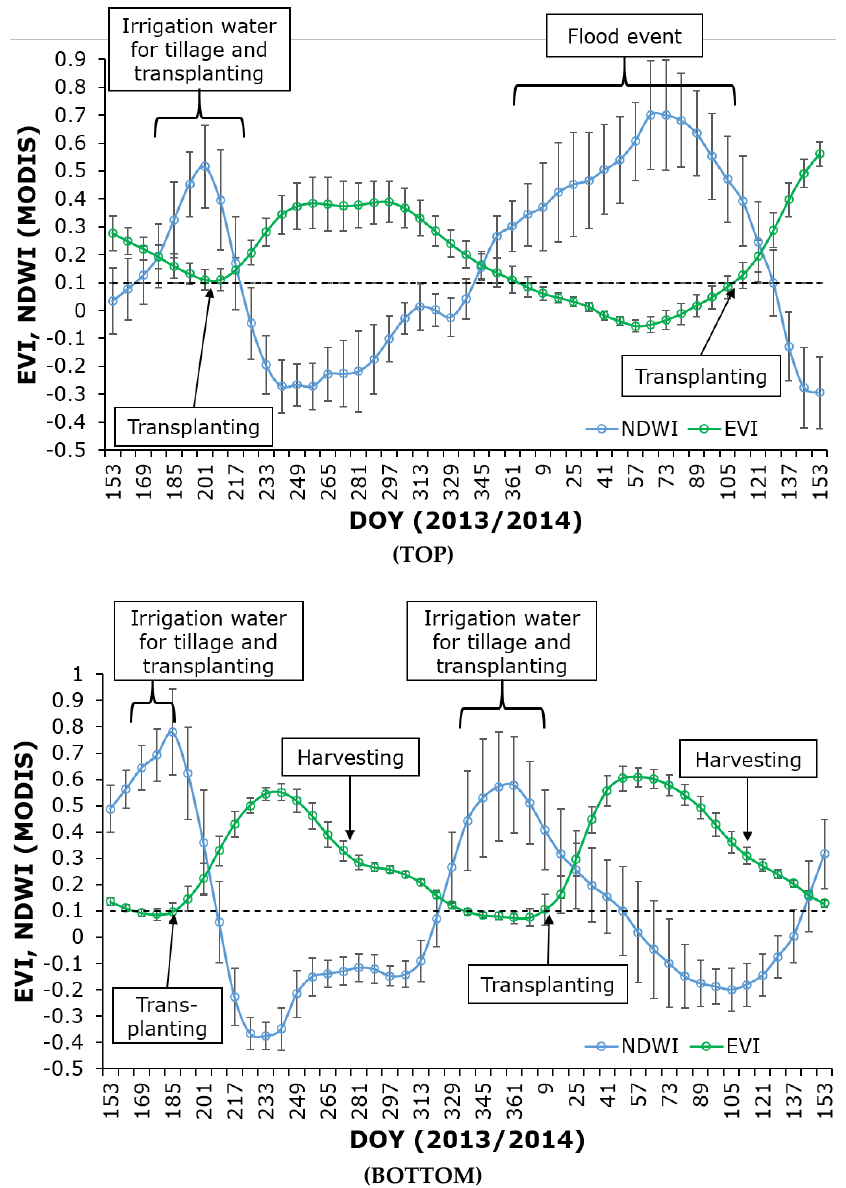
Figure 4. Examples of comparisons between MODIS EVI and MODIS NDWI profiles in rice fields with ( Top ) flooding and ( Bottom ) agronomic inundation. EVI provides information on transplanting dates and surface water duration needed to discriminate hazardous flooding and non-hazardous agronomic inundation. Locations for the top and bottom figures are Legonkulon, Subang and Pedes, Karawang, respectively.